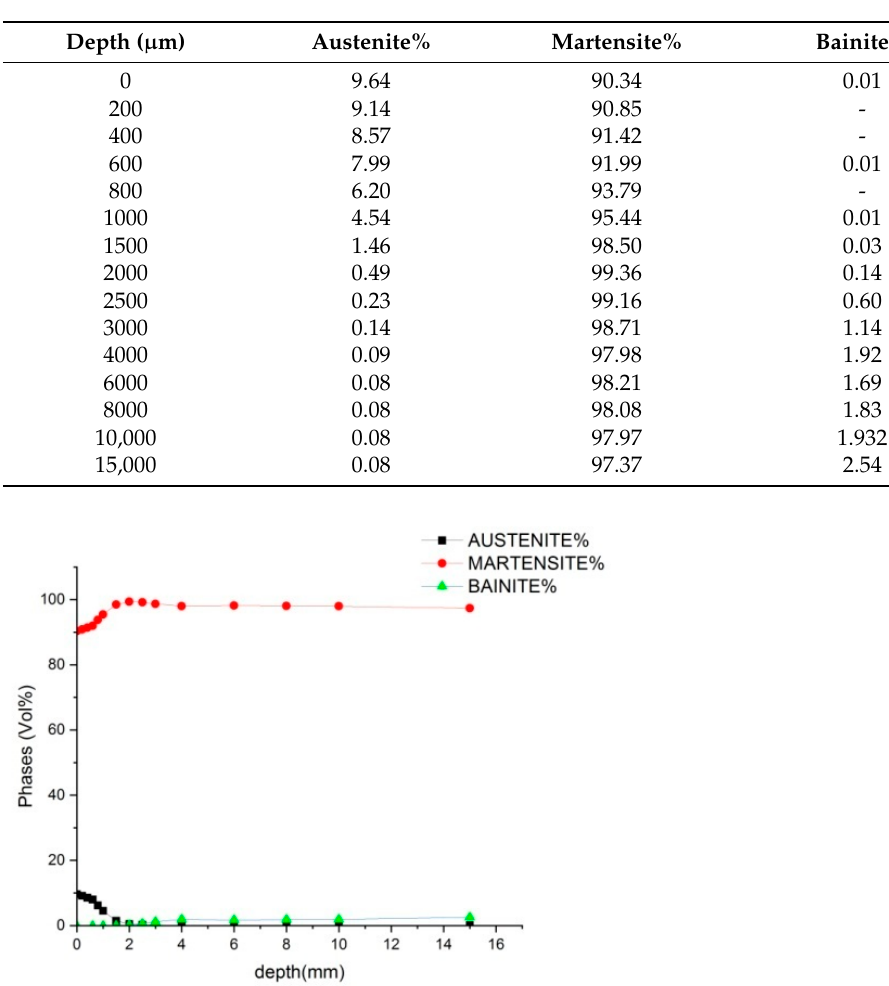
Table 7. Final distribution of steel from the case to the core.